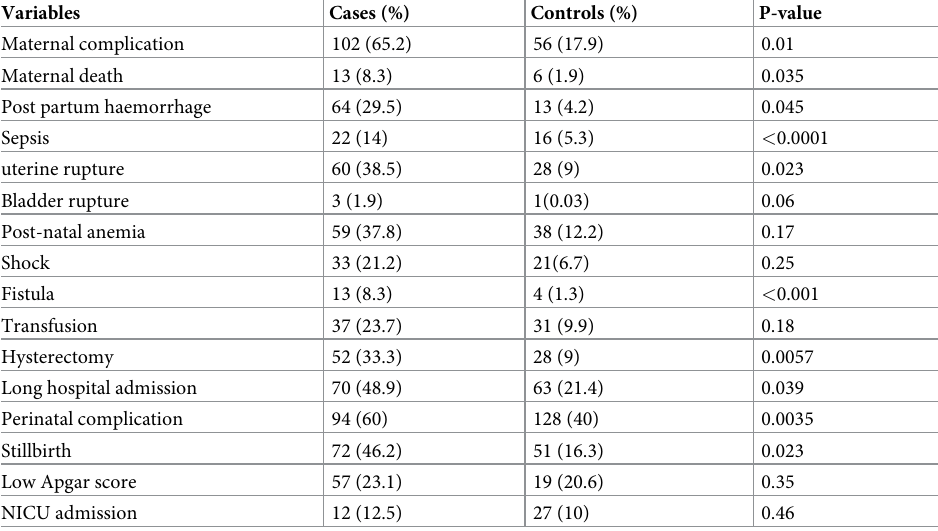
Table 4. Maternal and perinatal outcomes of obstructed labour in Hawassa University specialized Hospital, Southern Ethiopia.